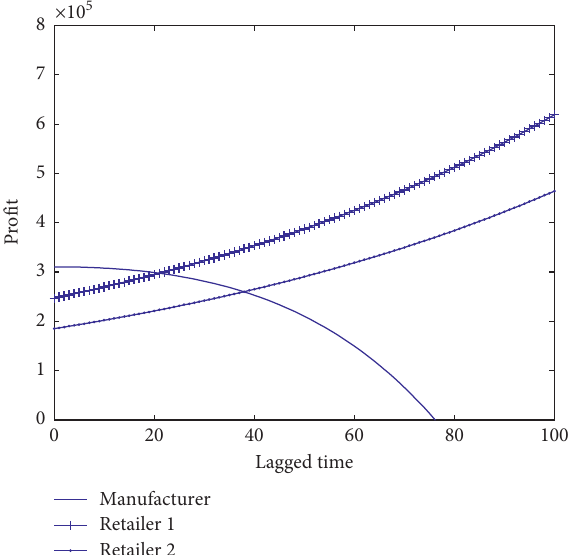
Figure 4: The effect of the lagged time on the profits of manufacturers and retailers under decentralized decision-making.